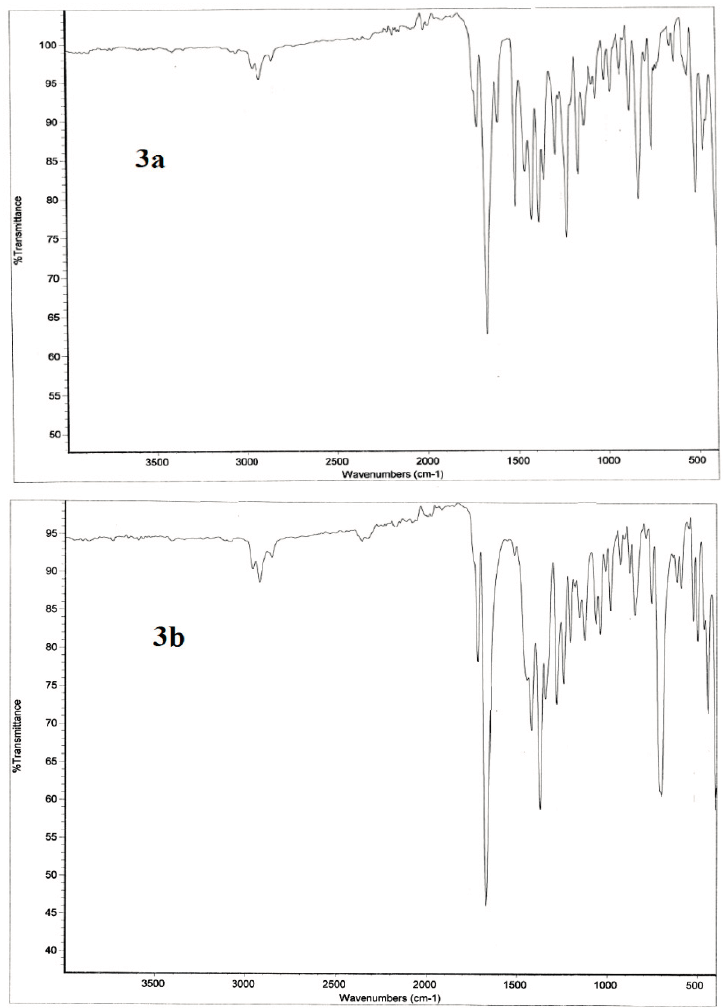
Figure 6. The experimental infrared vibrational spectra of the studied compounds 3a , b